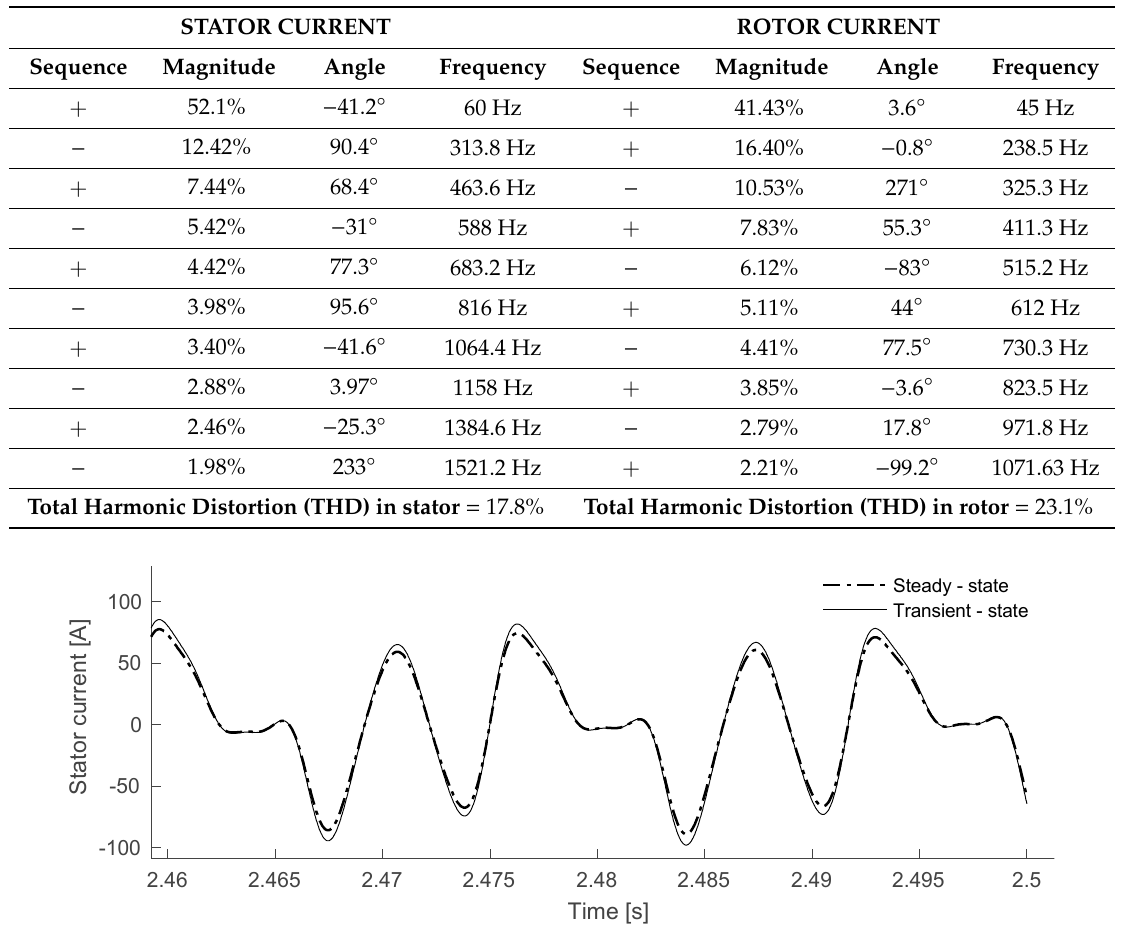
Table 7. Summary of harmonic currents for test case 2.